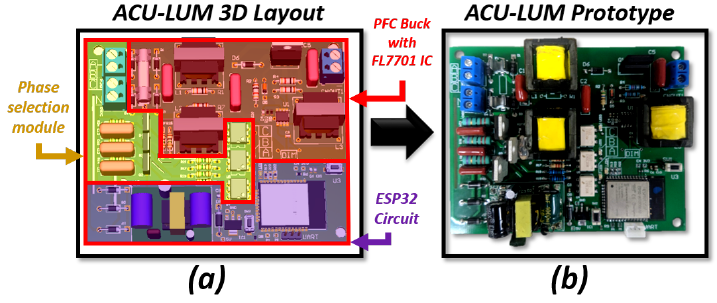
Figure 6. ACU-LUM 3D layout ( a ) and prototype ( b